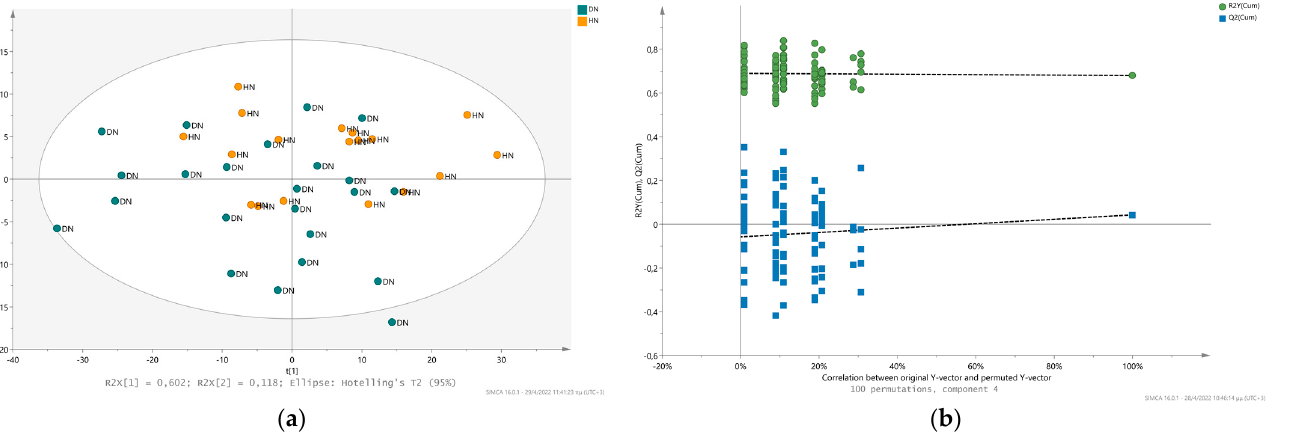
Figure 4. Urinary metabolic fingerprint Hypertensive Nephrosclerosis (HN) and Diabetic Nephropa- thy (DN): ( a ) PLS-DA 2D scores plot of 1 H 1D NOESY data matrix showing the clustering between HN (orange spheres) and DN (blue spheres) urine fingerprint; ( b ) Permutation plot of the PLS-DA model validating the statistical significance of the model as the permuted R 2 (green cycles) and Q 2 (blue squares) are lower than the original values of R 2 and Q 2 . Table 2. Univariate analysis of common urine metabolic features in DN and HN